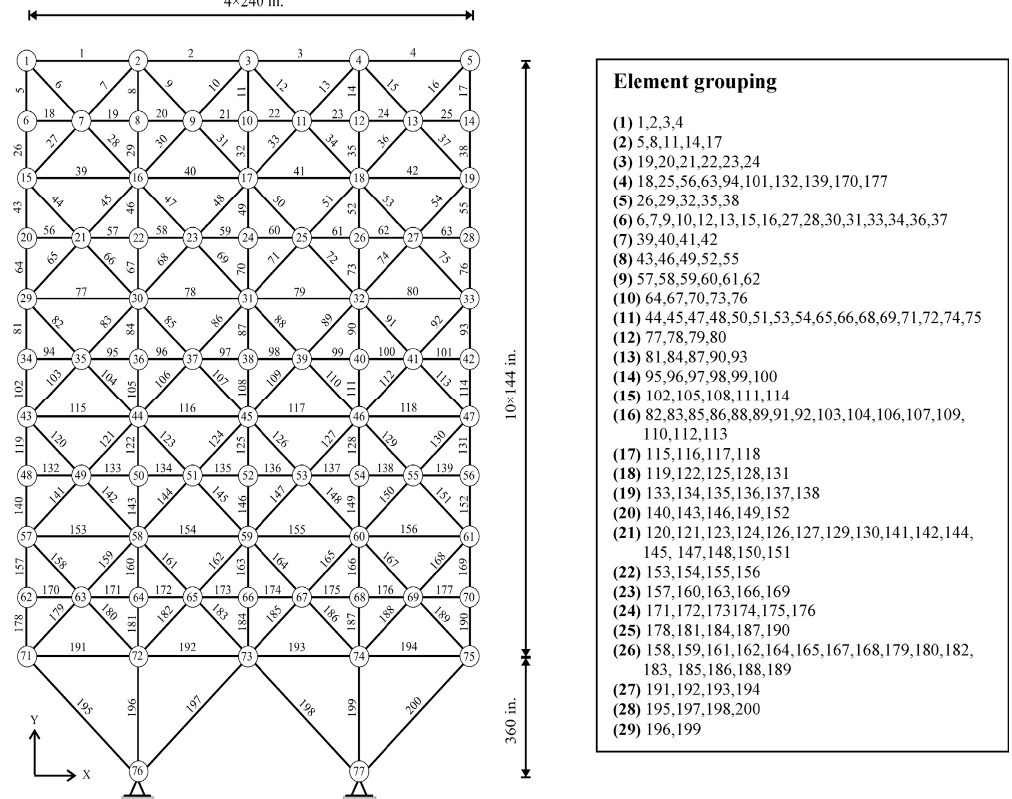
Figure 8. Schematic of the planar 200-bar truss structure. Table 10. Comparison of optimized designs for the 200-bar truss problem.